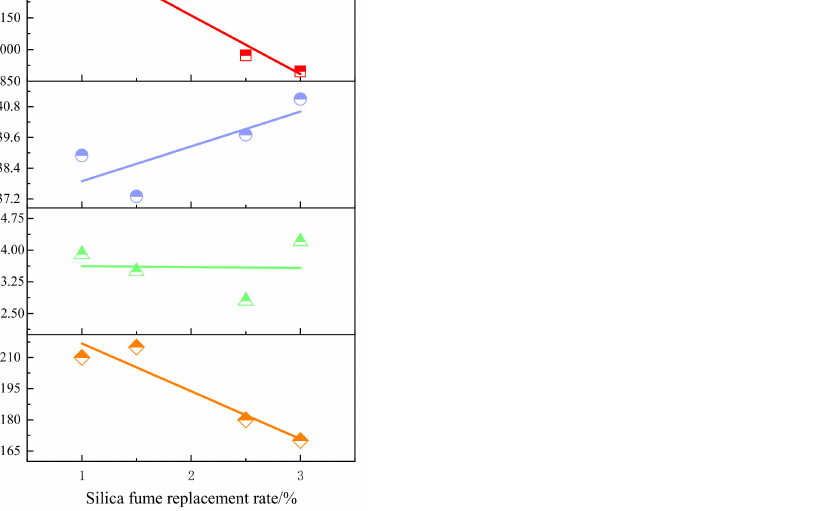
Figure 21. Effect of different amounts of silica fume on fluidity compressive strength and electric flux of coal gangue concrete